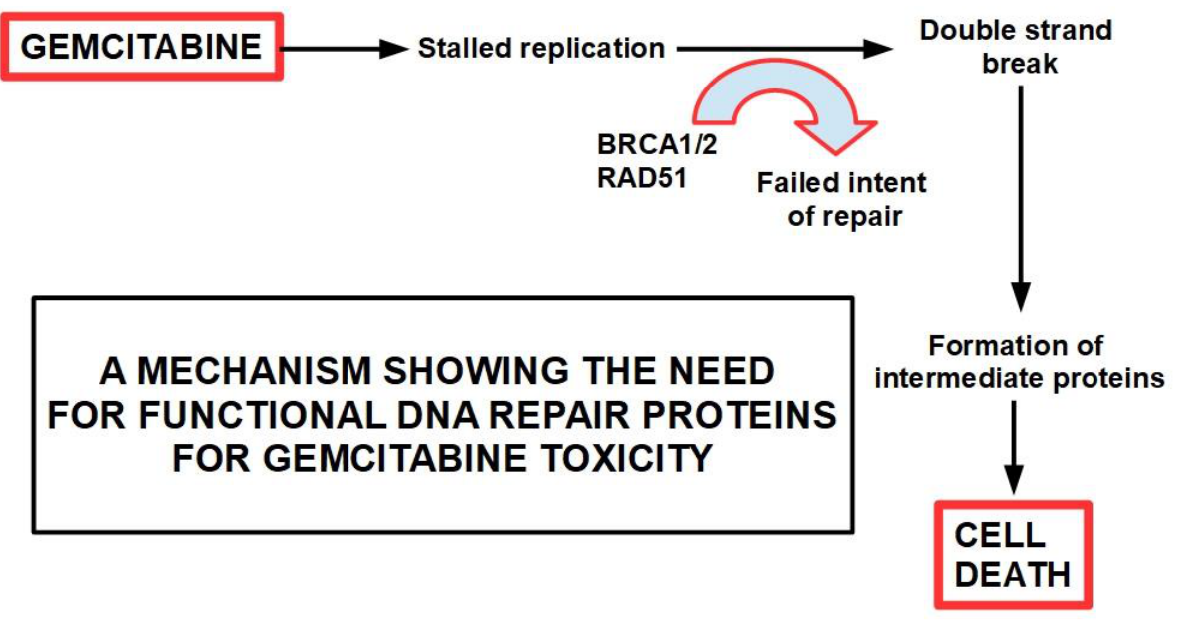
Figure 18. Role of DNA double-strand break-repair proteins in gemcitabine’s cytotoxicity. This evidence shows that gemcitabine would have a reduced cytotoxicity in germline mutated DNA repair genes and the association of gemcitabine with PARP inhibitors would not be synergistic but rather antagonistic.